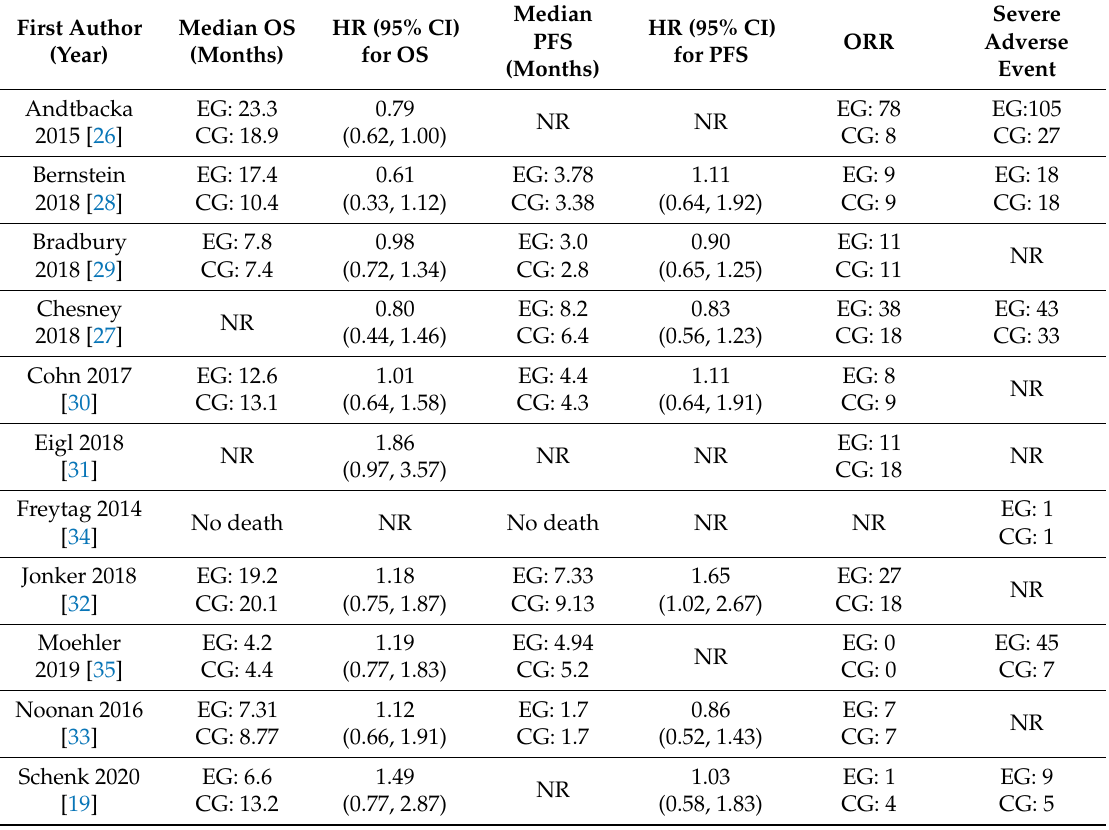
Table 2. Summary of outcomes in the selected